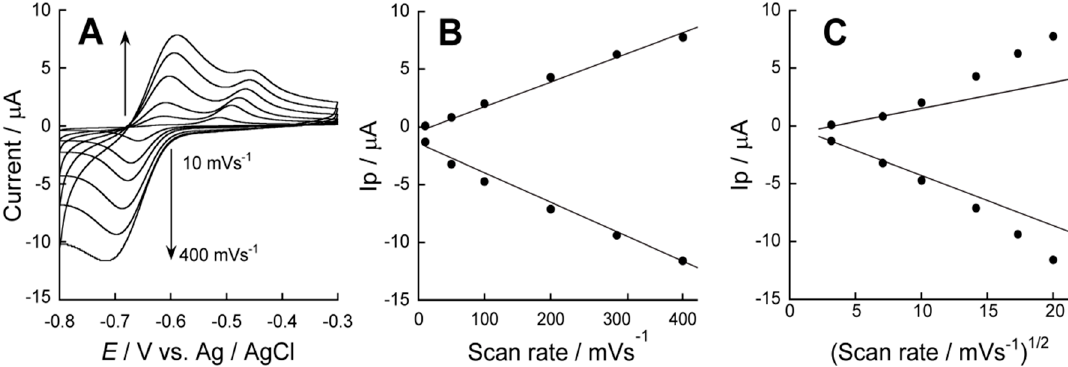
Figure 6. ( A ) The effect of the scan rate on the CV of the ARS-confined (PBA-PEI/CMC) 10 PBA-PEI film-coated electrode at pH 9.0; ( B ) plots of the anodic and cathodic peak current (Ip) at − 0.6 to − 0.7 V of the CV vs. scan rate; and ( C ) plots of the peak current of the CV vs. square root of scan rate.